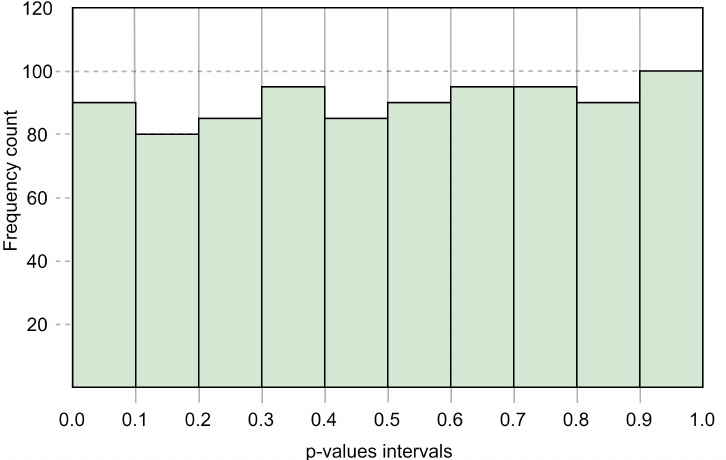
Figure 6. Distribution of p